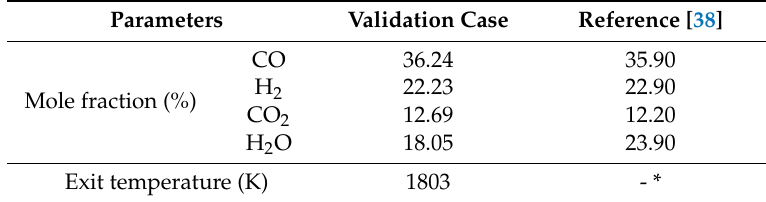
Table 6. Exit syngas temperature and major species of base